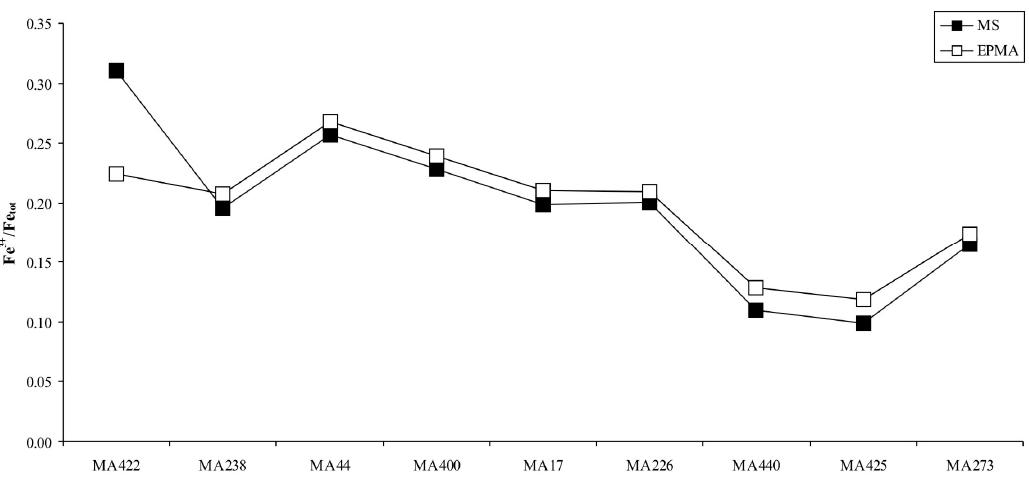
Figure 7. Fe 3+ /Fe tot comparison according to Mössbauer (MS) and Electron Microprobe Analysis (EMPA).